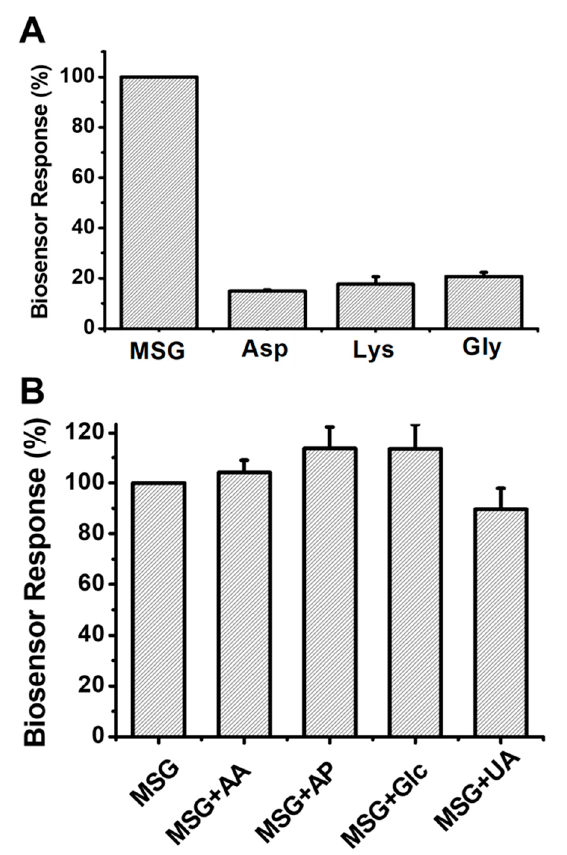
Figure 8. ( A ) Substrate specificity and ( B ) interference effects of some organic compounds on the response of the GCE/PCL–CHIT/PAMAM G1 –Mt/GluO x biosensor (Asp: aspartic acid, Lys: lysine, Gly: glycine, AA: ascorbic acid; AP: 3-acetamidophenol; Glc: glucose, UA: uric acid; in 50 mM, pH 6.5 sodium phosphate buffer, at − 0.7 V; error bars show the SDs of three measurements).